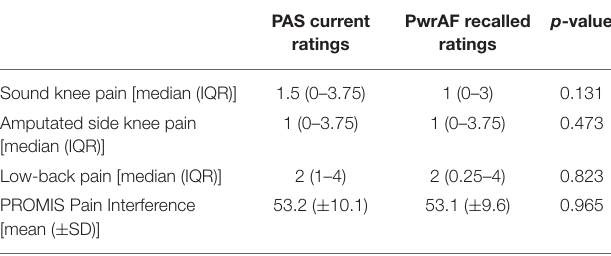
TABLE 3 | Original pain and pain interference in current PAS users. PAS current